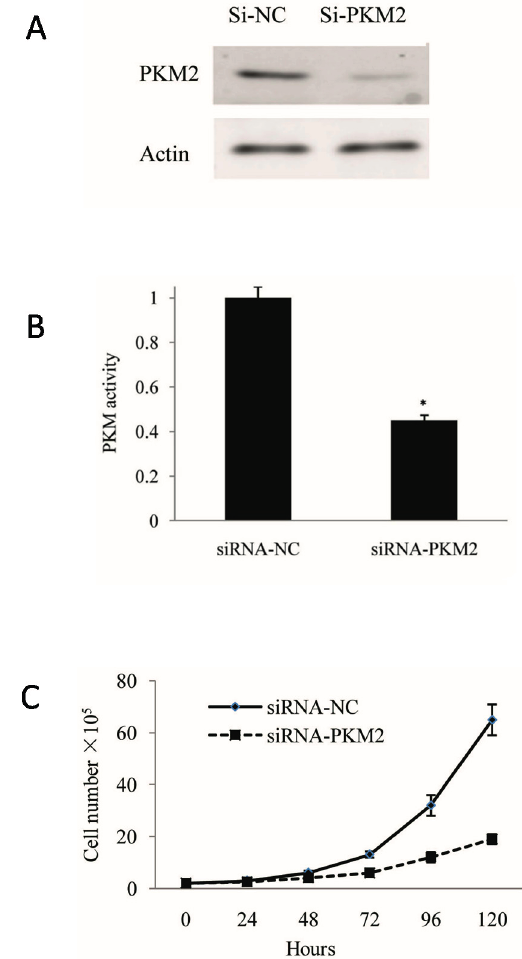
Figure 3. Effect of knockdown of PKM2 on proliferation of A549 cells. ( A ) PKM2 protein expression in si-NC and si- PKM2 A549 cells was detected by Western Blotting to evaluate the efficiency of PKM2 -knockdown at 72 h post-transfection; ( B ) PKM2 activity in si- PKM2 A549 cells, expressed as percentage of the enzyme activity in parental A549 cells at 72 h post-transfection; ( C ) Cell viability was determined by counting si- PKM2 A549 cells. * p < 0.05. The data shown are representative of three separate